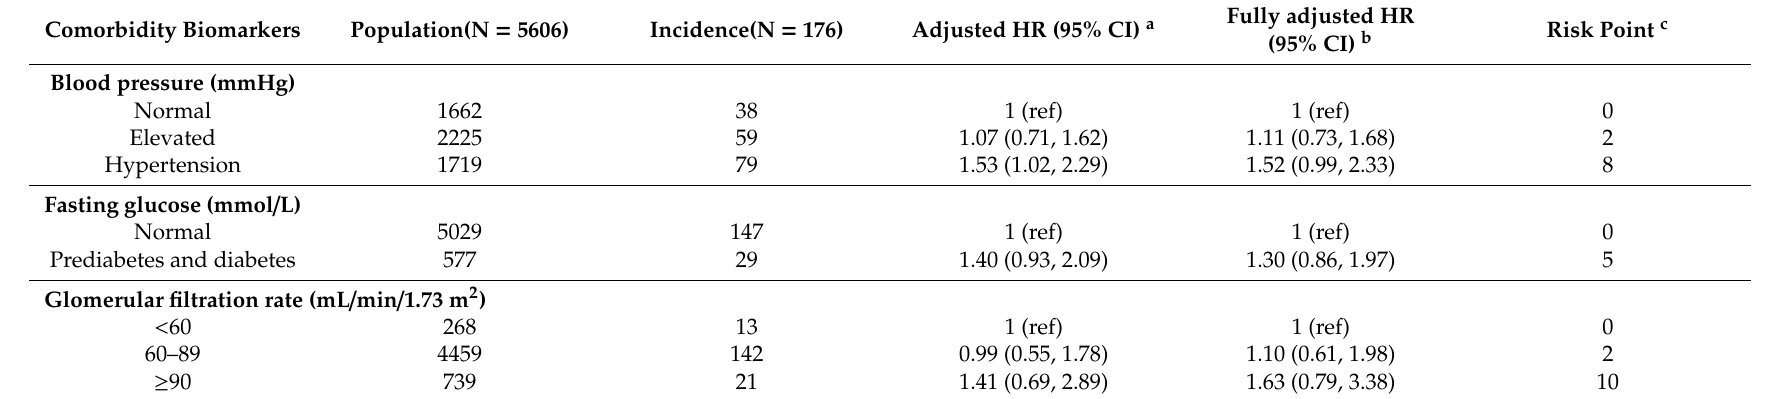
Table A3. Comorbidity biomarkers and the risk of cancer incidence after removing total cholesterol from comorbidity risk score.